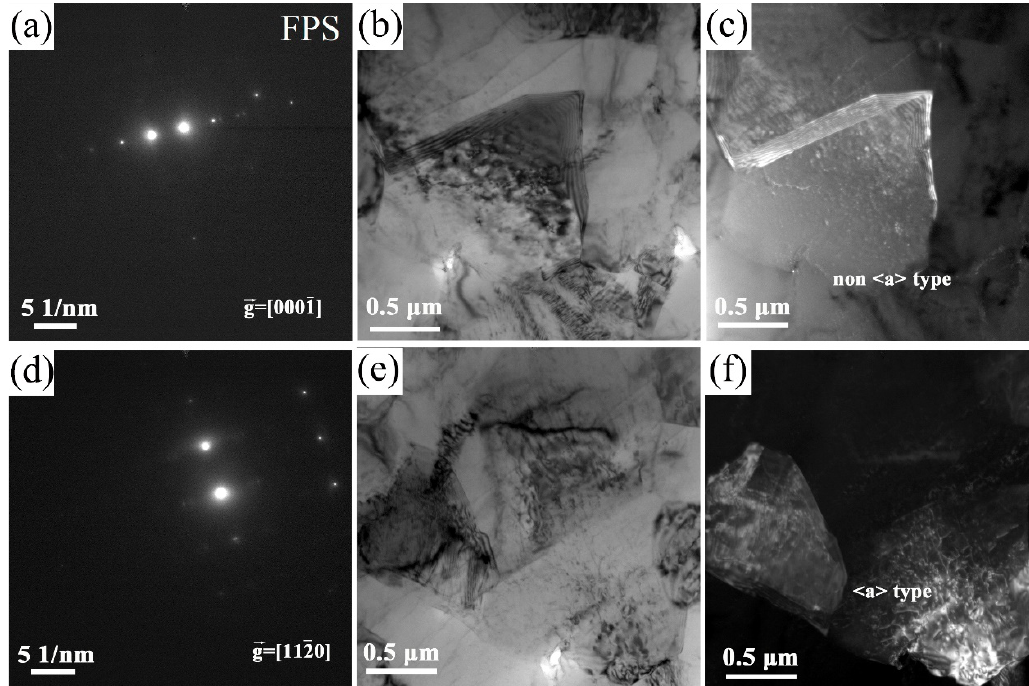
Figure 6. TEM images of initial dislocations in heat-treated and milled-out sample (FPS) (11.6 μm grain size): ( a – c ), non- < a > type (g = [0001]), B close to [1010 ]); ( d – f ), < a > type (g = [1120 ], B close to [1010